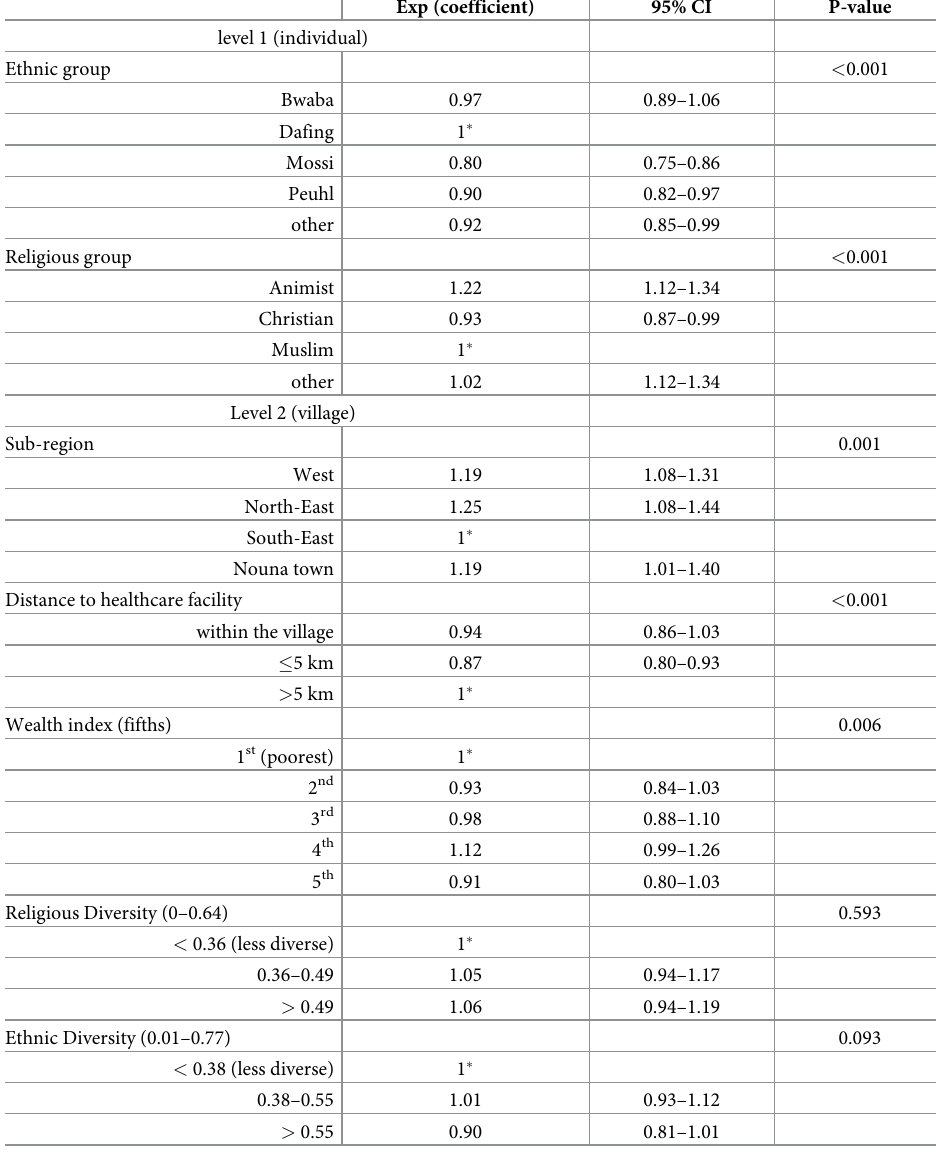
Table 3. Multilevel Poisson regression of the standardized mortality ratio with random intercepts on the village